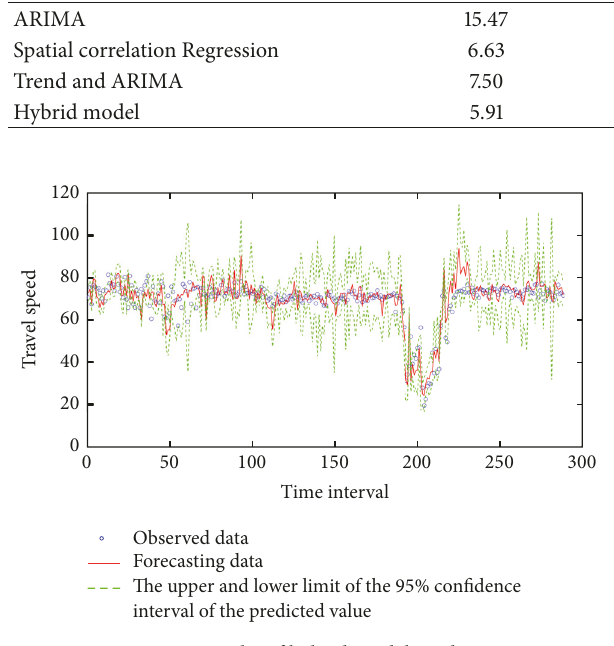
Figure 9: Results of hybrid model